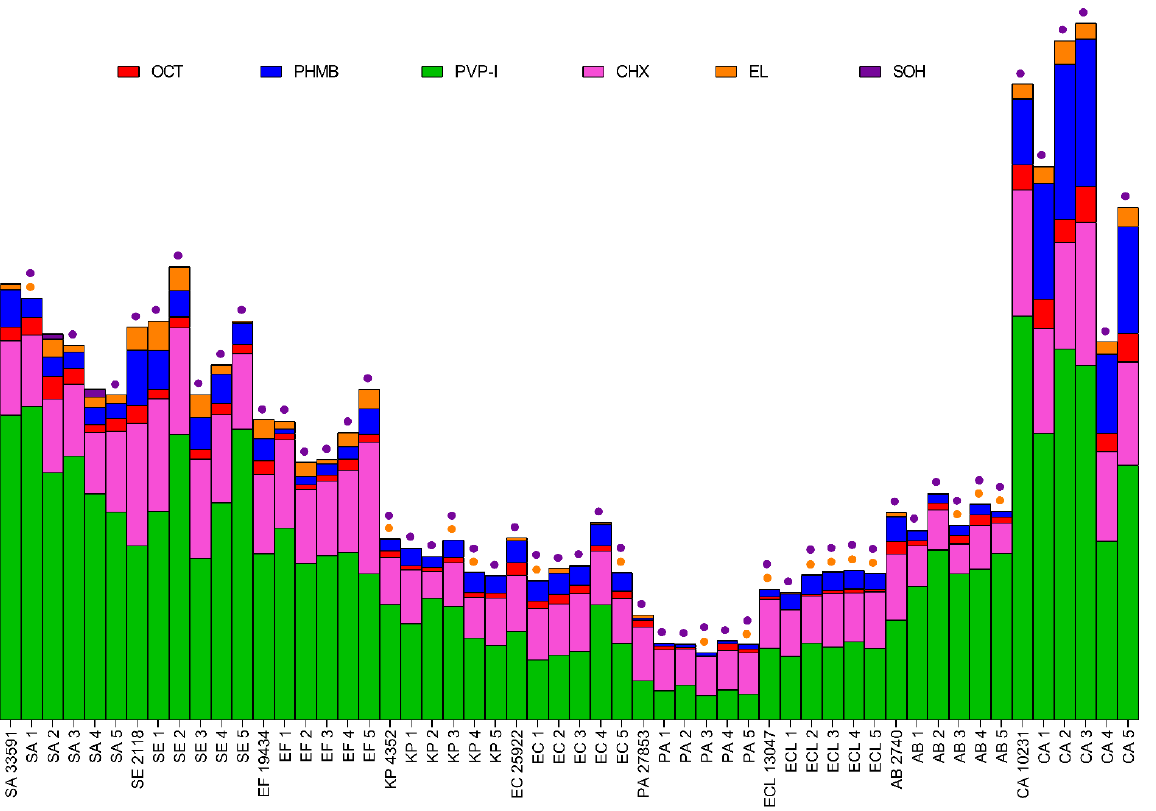
Figure 12. Comparison of surface areas of growth inhibition zones (mm 2 ). SA — Staphylococcus aureus , SE — Staphylococcus